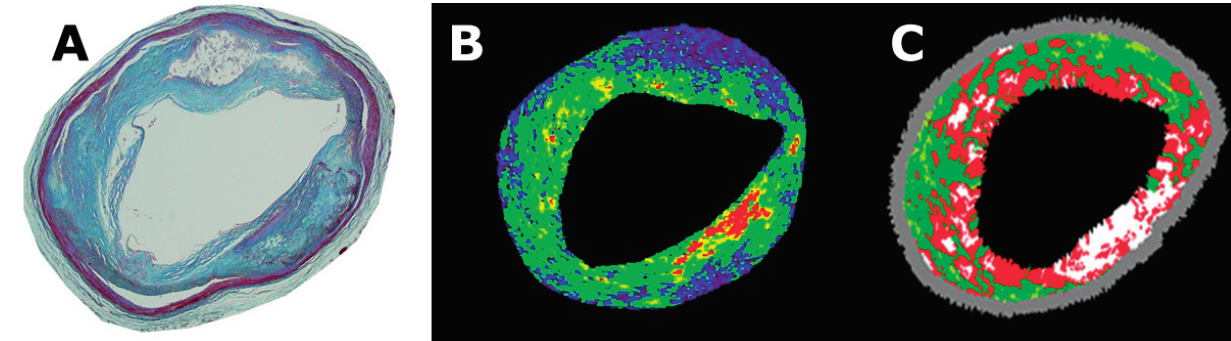
Figure 7. Representative IB-IVUS and VH-IVUS images of the same segment. ( A ) Histological image; ( B ) Corresponding IB-IVUS image; ( C ) Corresponding VH-IVUS